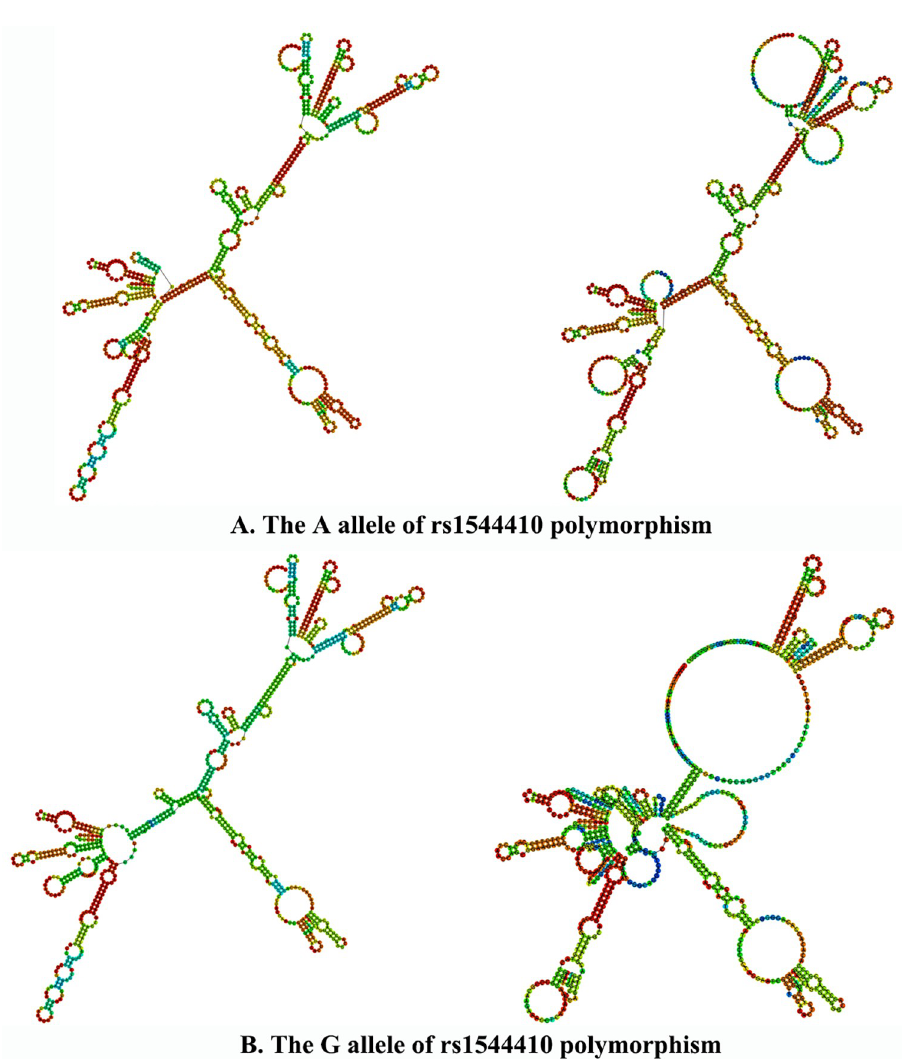
Fig 7. The RNAfold structure analysis of the VDR rs1544410 polymorphism. A: rs2228570 polymorphism; B: rs731236 polymorphism. VDR = vitamin D receptor.